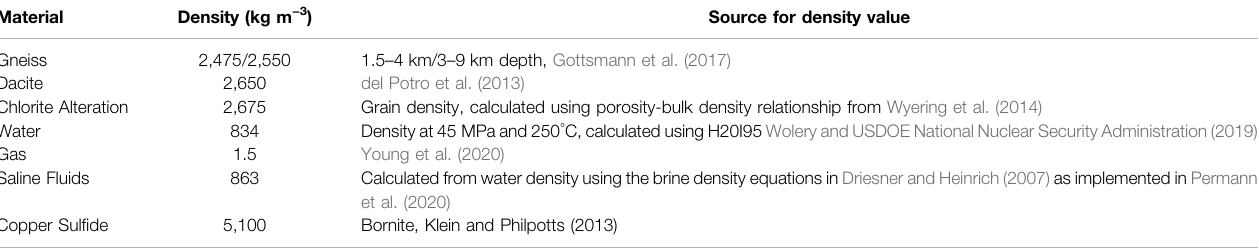
TABLE 3 | Density values for parameter space exploration ( Figure 10